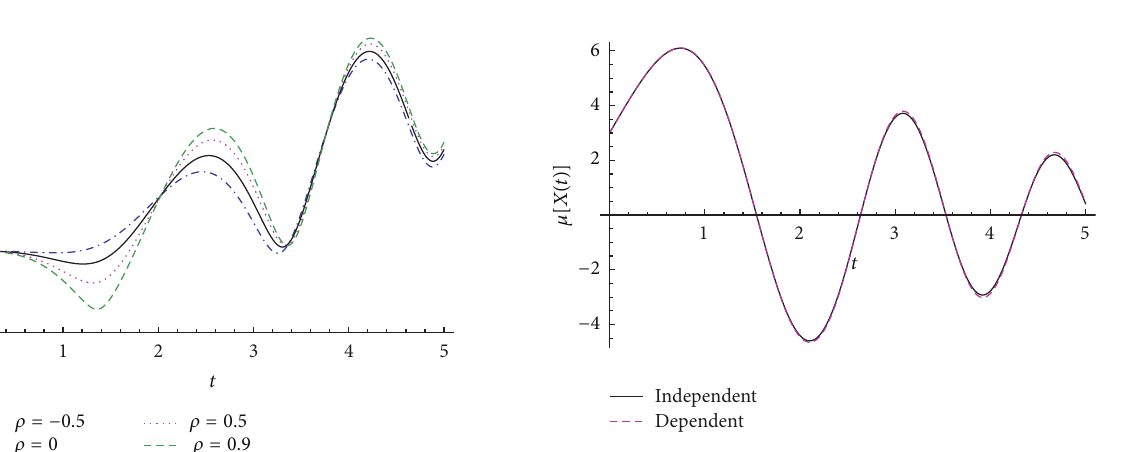
Figure 3: Comparison of the approximations for the expectation 𝜇[𝑋(𝑡)] on the time-interval 𝑡 ∈ [0, 5] in Example 3 by using Fr¨obenius, Polynomial Chaos, and Monte Carlo simulations. Since thenumericalvaluesareindistinguishablegraphically,forthesakeof clarityinthepresentation,nonlabelhasbeenintroduced.Weassume that 𝜂 = (𝐴, 𝑌 0 ,𝑌 1 ) ⊤ follows a multivariate Gaussian distribution: ; Σ ) where 𝜇 = (4, 3,6) ⊤ and Σ 1 Σ 2 𝜂 ∼ 𝑁( 𝜇 𝜂 𝜂 𝜂 𝜂 and 𝜂 are given by (35) corresponding to statistical independence and dependence, respectively.